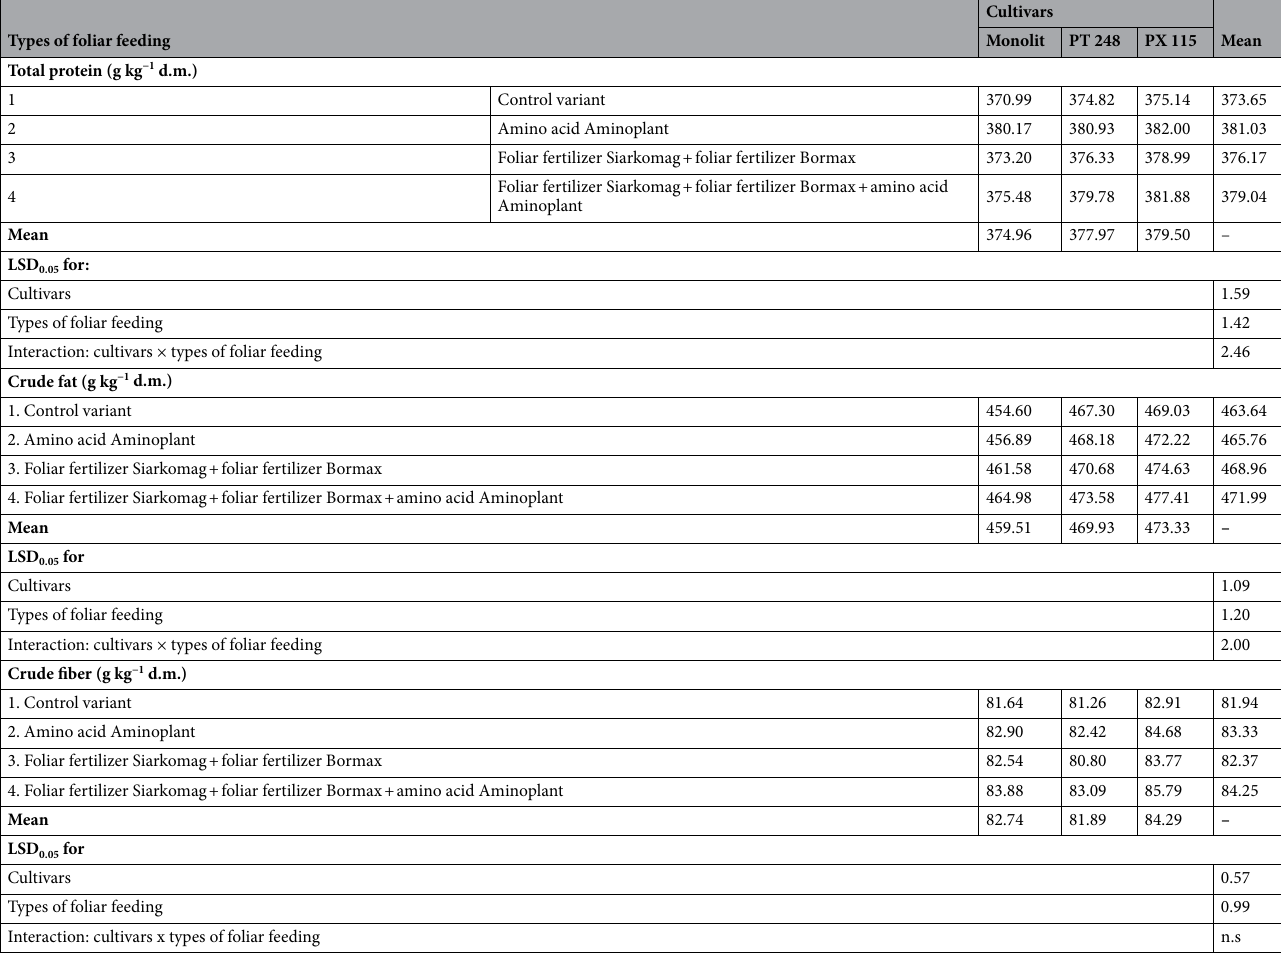
Table 1. Chemical composition of rapeseed depending on the types of foliar nutrition and varieties of foliar nutrition. d.m. dray matter, n.s. not